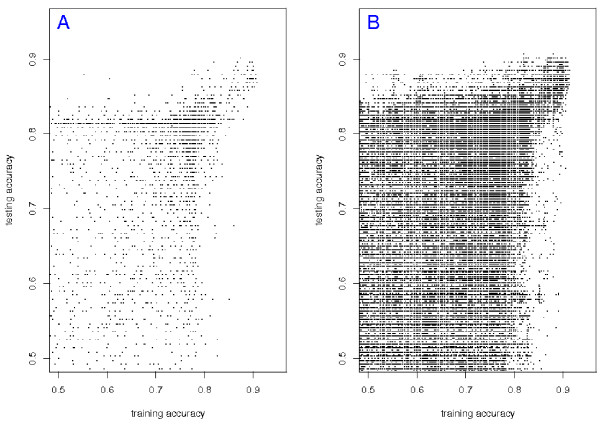
Reproducibility of top-scoring pairs and triples. Panel A: Each point represents a candidate gene pair. For each pair, the probabilities of the two orderings are estimated on the combined expObreast and Miller datasets and the classifier is tested on Sotiriou. The x-coordinate of a point represents the training accuracy and the y-coordinate represents the testing accuracy. Panel B: Same as left panel, but for all triples of genes.